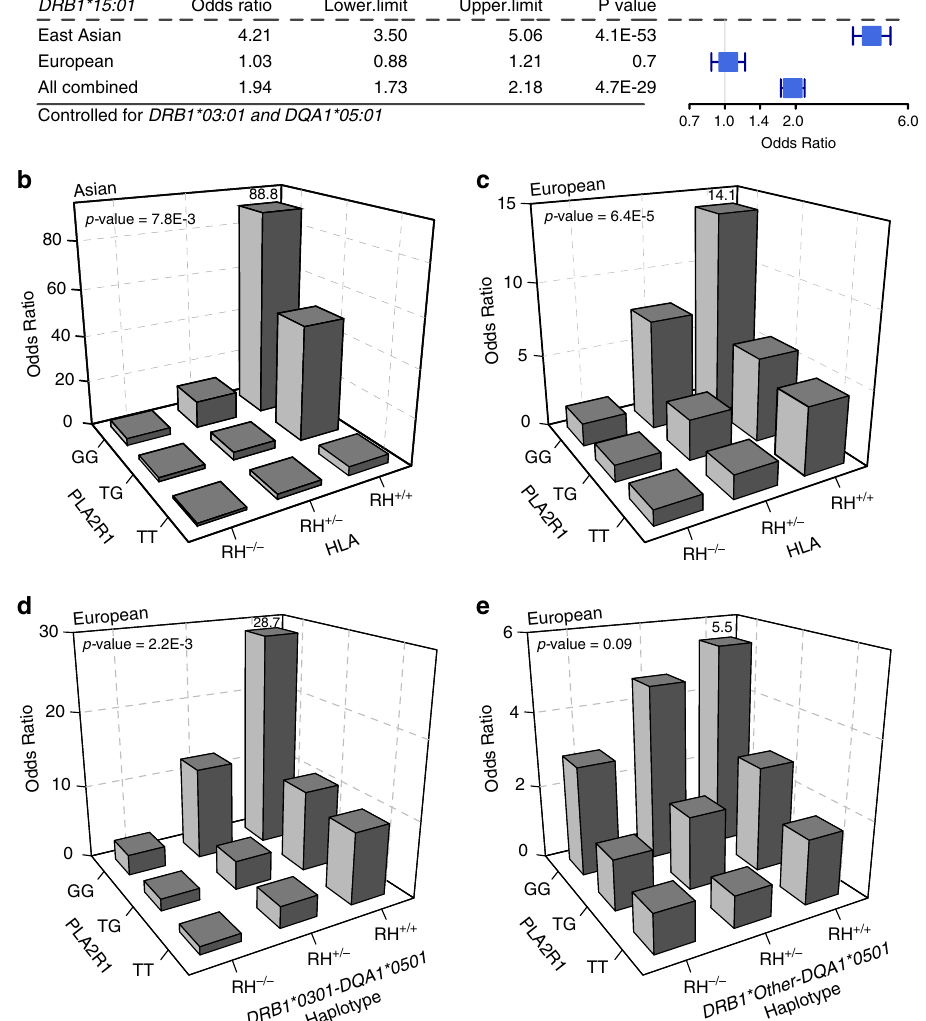
Fig. 4 Ethnicity-speci fi c HLA allelic effects and genetic interactions. a Stepwise conditioning of HLA risk alleles by ethnicity; Top : Unconditioned effect estimates, 95% con fi dence intervals, and P -values for DRB1*0301 demonstrate similar effects in East Asian and European cohorts. Middle: Effect estimates for DQA1*0501 after controlling for DRB1*0301 demonstrate signi fi cant heterogeneity, with stronger effects in the European cohorts (Cochrane ’ s Q P- value< 0.05). Bottom: Effect estimates for DRB1*1501 after controlling for both DRB1*0301 and DQA1*0501 demonstrate signi fi cant heterogeneity with risk effect in East Asians but no effect in Europeans (Cochrane ’ s Q P- value<0.05). b PLA2R1 genotype interaction with East Asian HLA risk haplotypes, DRB1*0301 or DRB1*1501 (N cases/controls = 803/1,956, P = 7.8× 10 − 3 ). c PLA2R1 genotype interaction with European HLA risk haplotypes, DRB1*0301 or DQA1*0501 ( N cases/controls = 1880/2627, multiplicative interaction test P = 6.4× 10 − 5 ). d PLA2R1 genotype interaction with DRB1*0301-DQA1*0501 risk haplotype in Europeans (multiplicative interaction test P = 2.2× 10 − 3 ). e No signi fi cant interaction between PLA2R1 and DQA1 risk haplotypes other than DQA1*0501 - DRB1*0301 in Europeans (multiplicative interaction test P = 0.09). RH risk